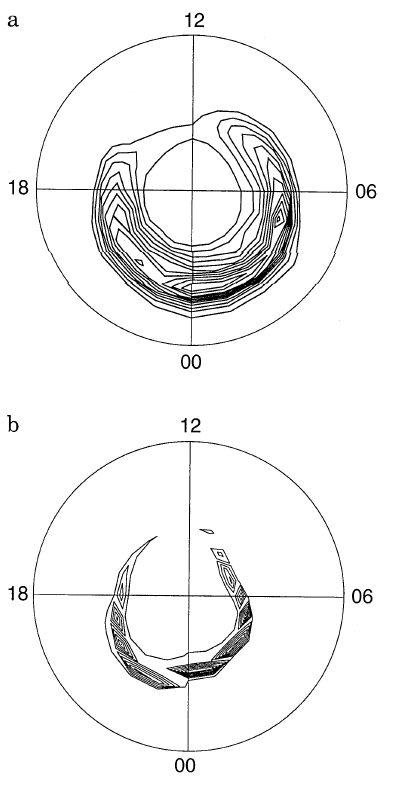
Fig. 2a, b. Energetic-particle precipitation patterns for Kp " 4o on a magnetic latitude vs. MLT grid. a Particle precipitation distribu- tion of Hardy et al . (1985); b new particle precipitation distribution derived from Hardy et al . (1985). The perimeter latitude is 50 ° N